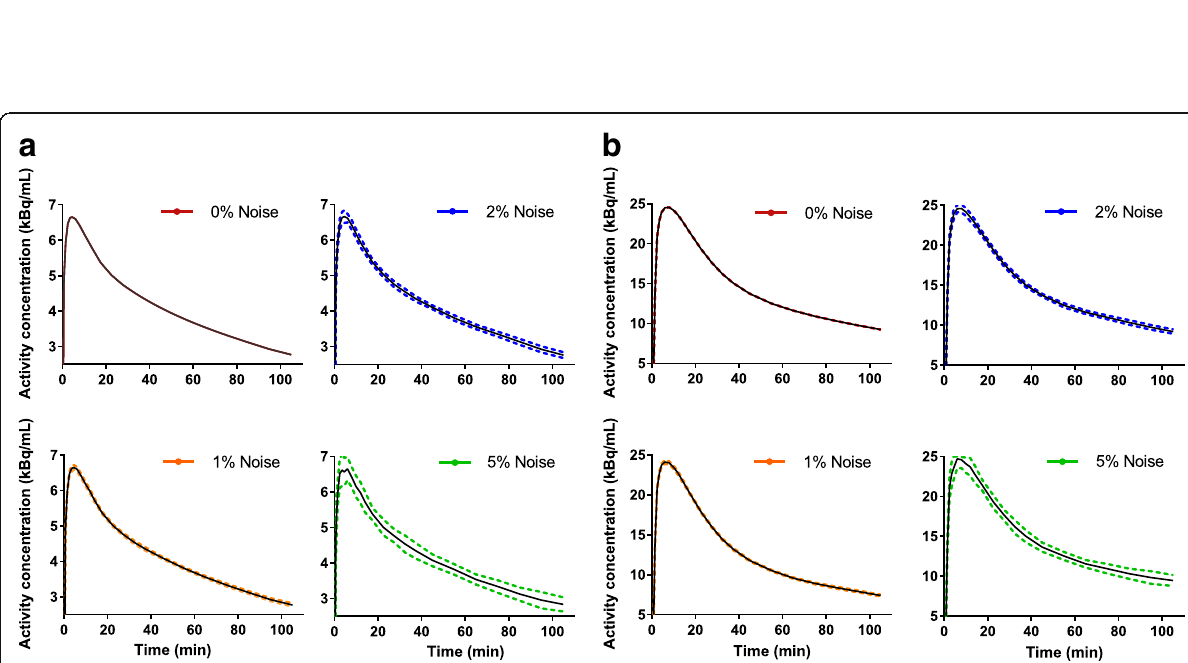
Fig. 3 SRTM simulated TACs from a global cortical region (mean TAC value ± SD, shown solid and dashed lines, respectively) for all noise levels (COV 0 – 5%) for a [ 18 F]flutemetamol and b [ 18 F]florbetaben. All TACs were simulated using a BP sim